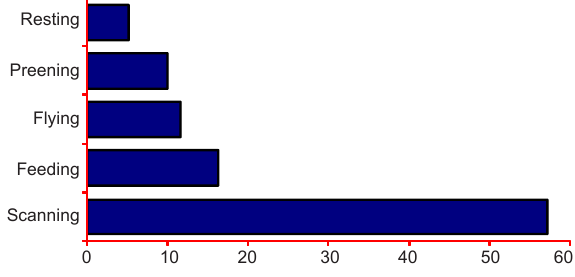
Figure 4. Overall (%) diurnal activities of the Indian